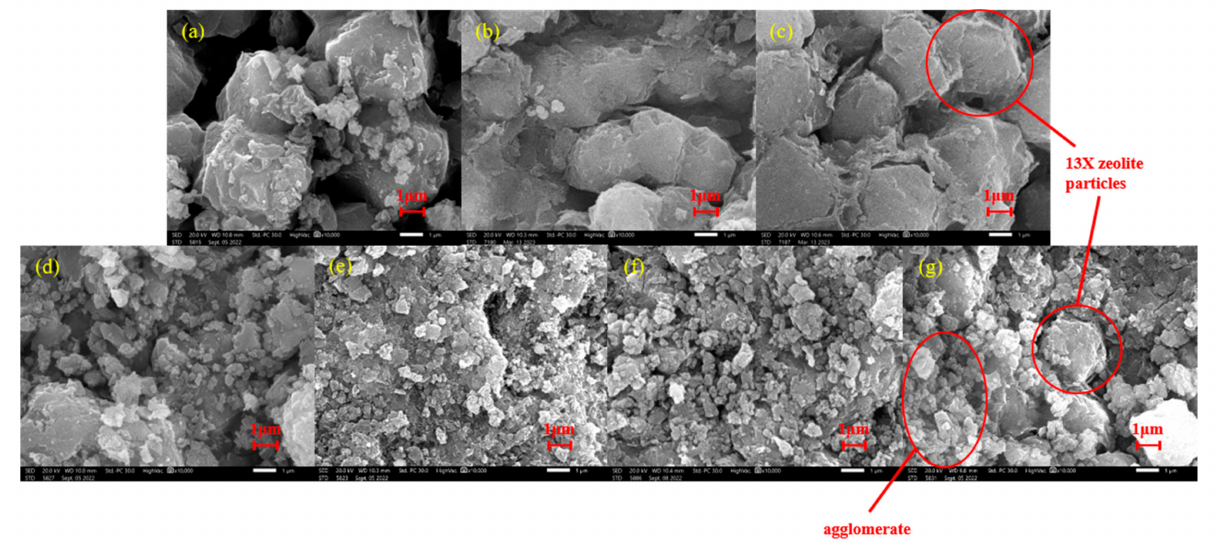
Figure 6. SEM images of the adsorbent with the impregnating solution concentration of ( a ) 0 mol/L, ( b ) 0.05 mol/L, ( c ) 0.1 mol/L, ( d ) 0.15 mol/L, ( e ) 0.2 mol/L, ( f ) 0.3 mol/L and ( g ) 0.4 mol/L,